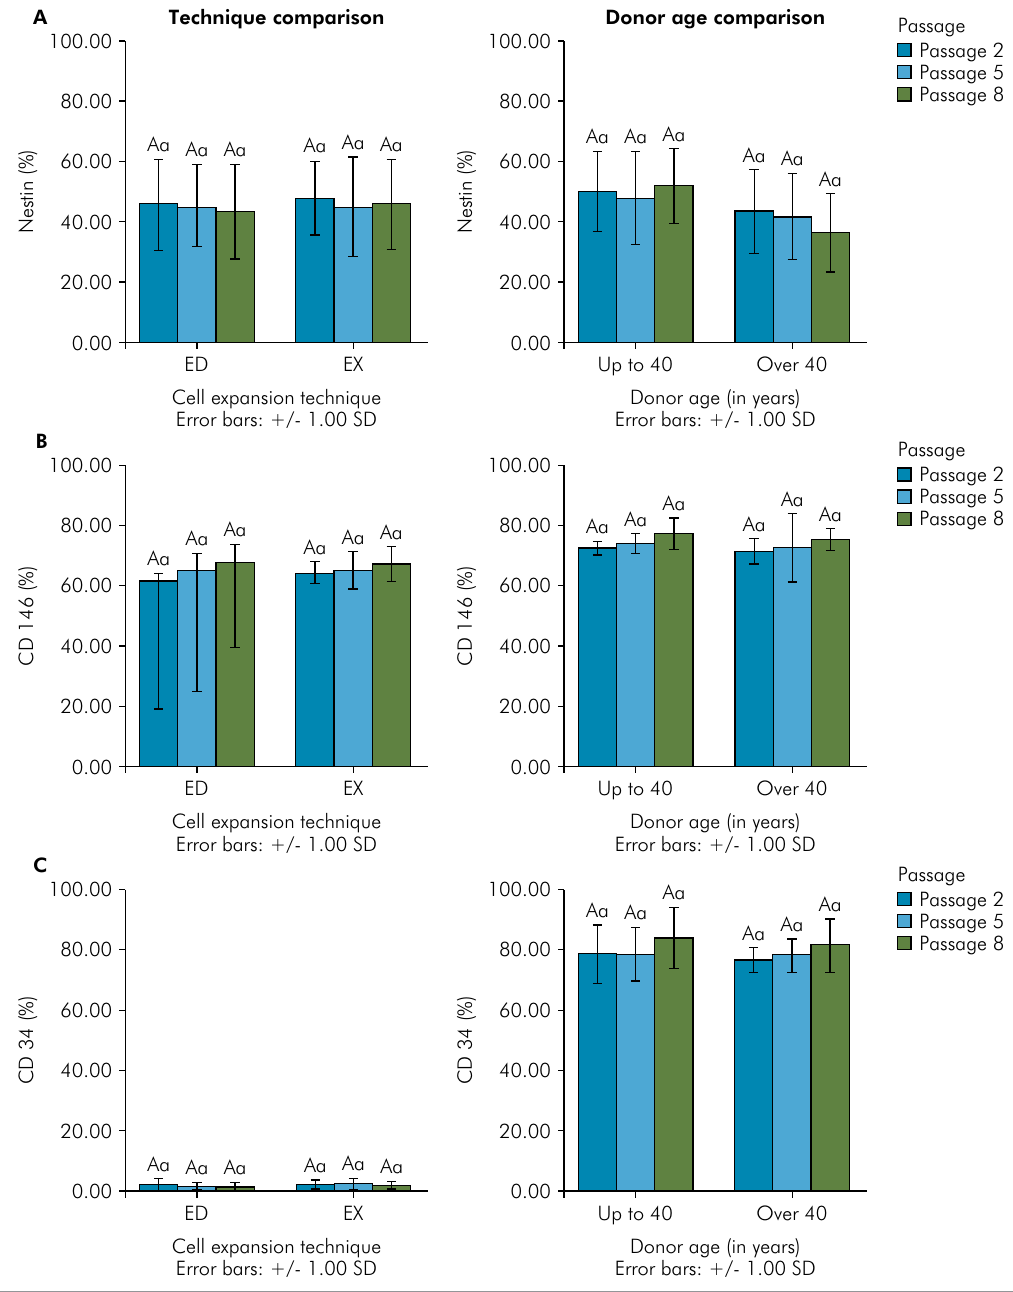
Figure 6. Concentration (%) of dental pulp stem cells (DPSCs) positively marked with nestin (A), CD146 (B) and CD34 (C) in passages 2, 5 and 8. In the left column, cell expansion techniques are being compared, while in the right column, the comparison is between donor age (in years) groups (up to 40/over 40). There was no significant statistical difference detected for all comparisons (ANOVA,